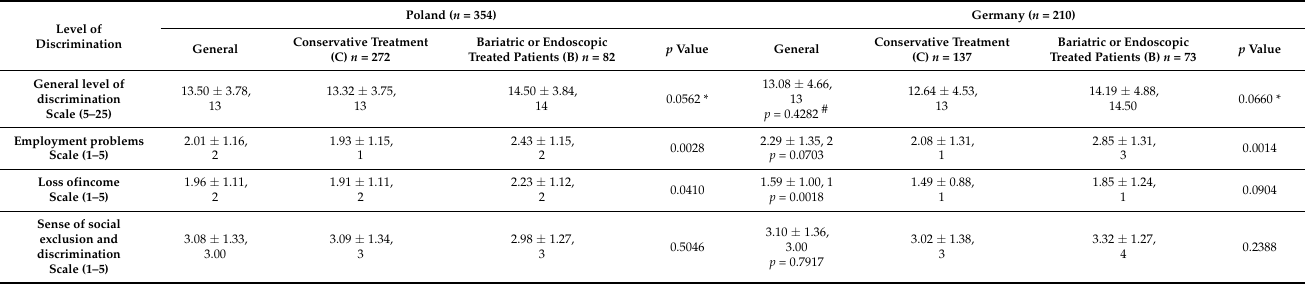
Table 2. A comparative analysis of the level of discrimination among obese patients from Poland and Germany depending on the type of treatment ( n =